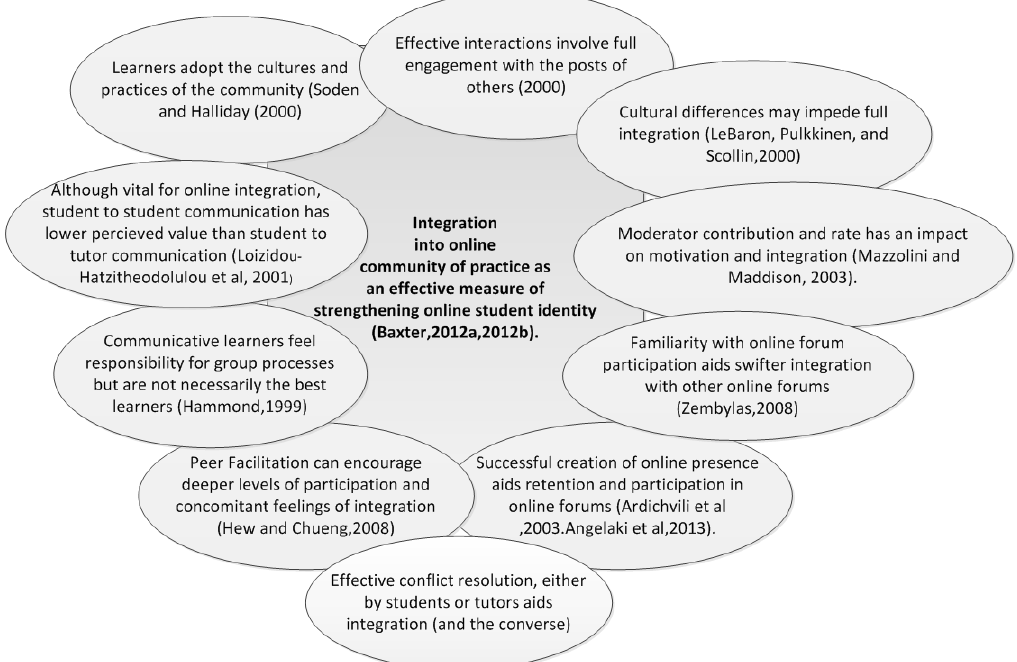
Figure 2 . Key findings from current literature on